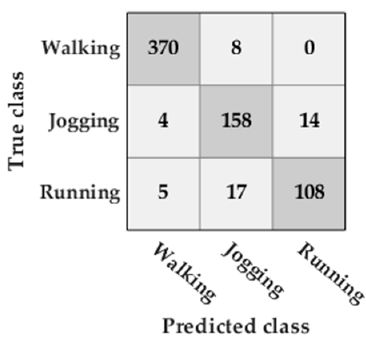
Figure 12. Confusion matrix of the classification of the type of activity classification in the FAU dataset activities.